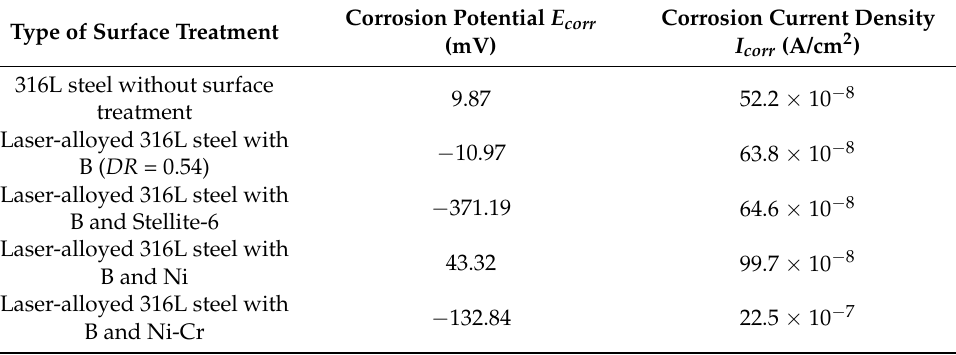
Table 8. Corrosion potential E corr and corrosion current density I corr of laser-alloyed layers, produced in 316L austenitic steel, compared to the same material without surface treatment based on the polarization curves in 3.5% NaCl